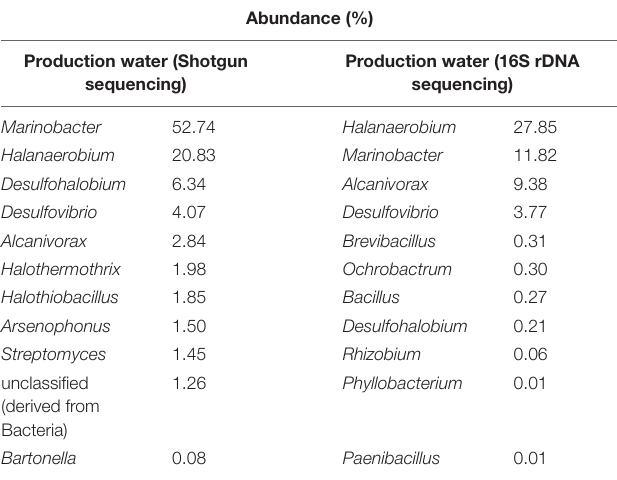
TABLE 1 | Relative abundance of genera in production water by shotgun metagenomic and rDNA 16S sequencing methods. Abundance